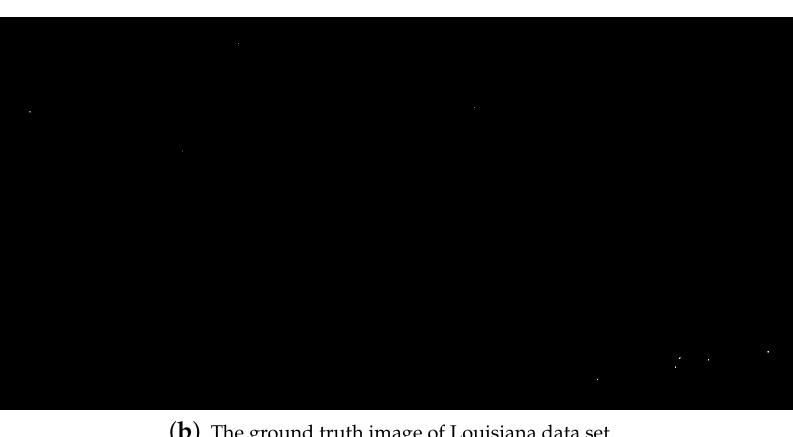
( a ) The colour image of Louisiana dataset (anomalies located in the square).